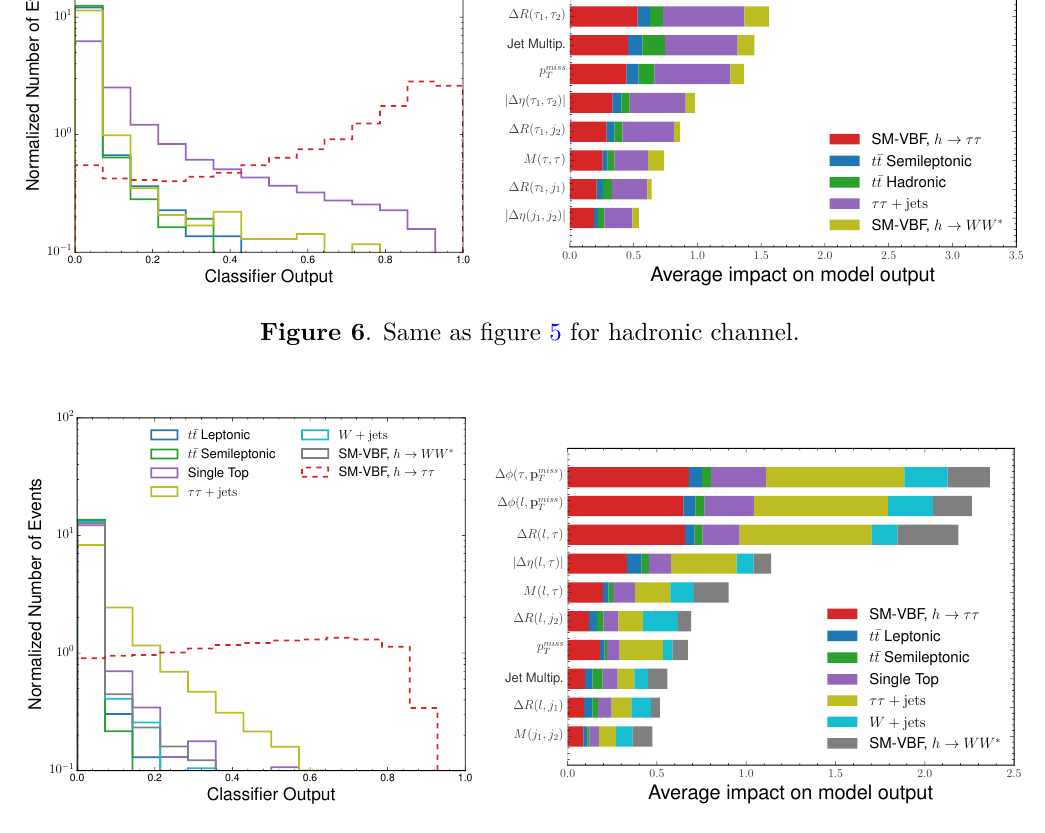
Figure 7 . Same as figure 5 for semileptonic